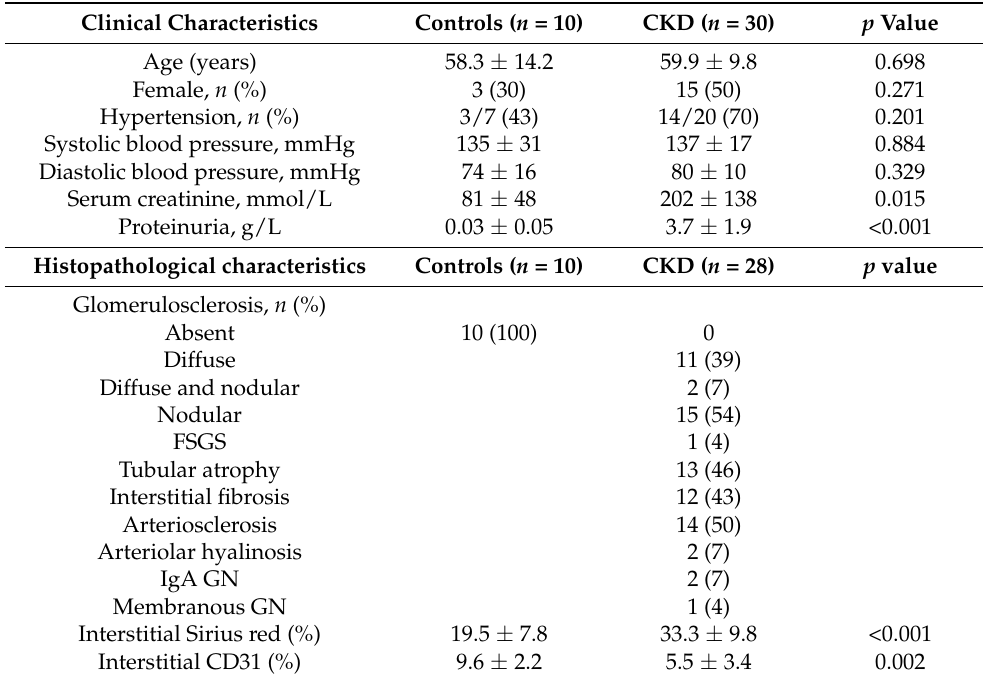
Table 3. Clinical and histopathological characteristics of controls and diabetic CKD